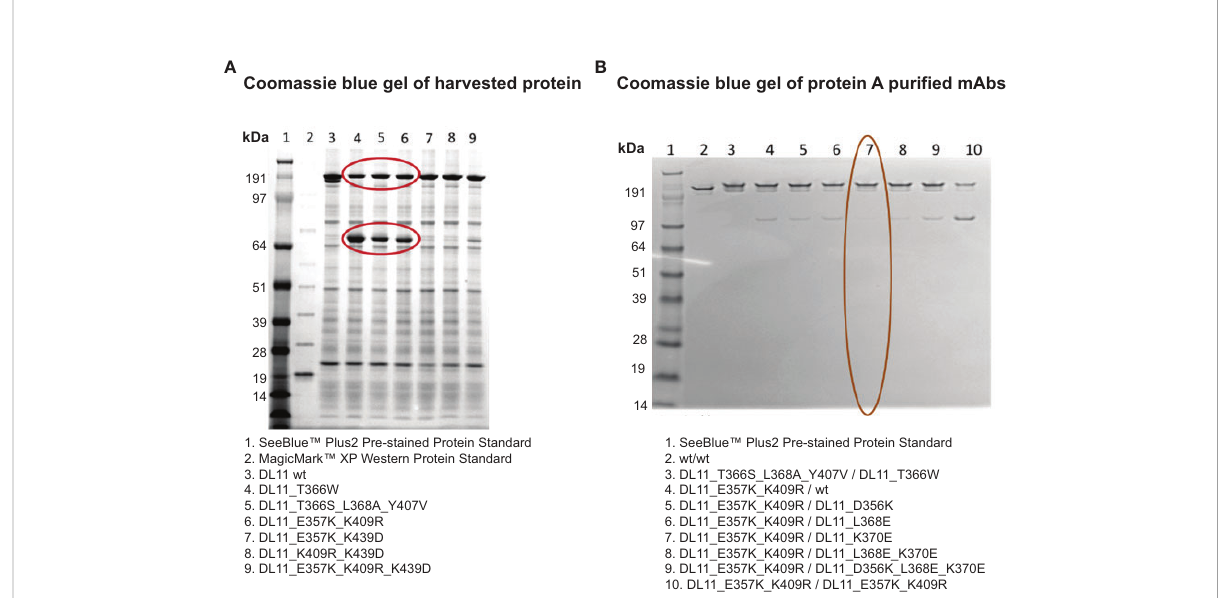
FIGURE 2 Identi fi cation of lead C H 3 mutations for Fc heterodimer formation using non-reducing SDS-PAGE analysis. Non-reducing SDS-PAGE of representative Fc engineered antibodies are shown in (A) . Protein samples were harvested. Gel was stained with Coomassie blue. Mutations that induce the formation of half-antibody fragments are circled. These include the published knobs-into-holes mutations ( lanes 4 & 5 ) and the computationally engineered variant (lane 6). (B) Identi fi cation of compensatory Fc mutations using a three-chain system (2 heavy and 1 light). The Fc mutations shown in column 7 (circled in red) show maximum reduction in the formation of half-antibody fragments, similar to the traditional knob-into-holes mutations (column 3). Lane 1 in A and B contains SeeBlue protein